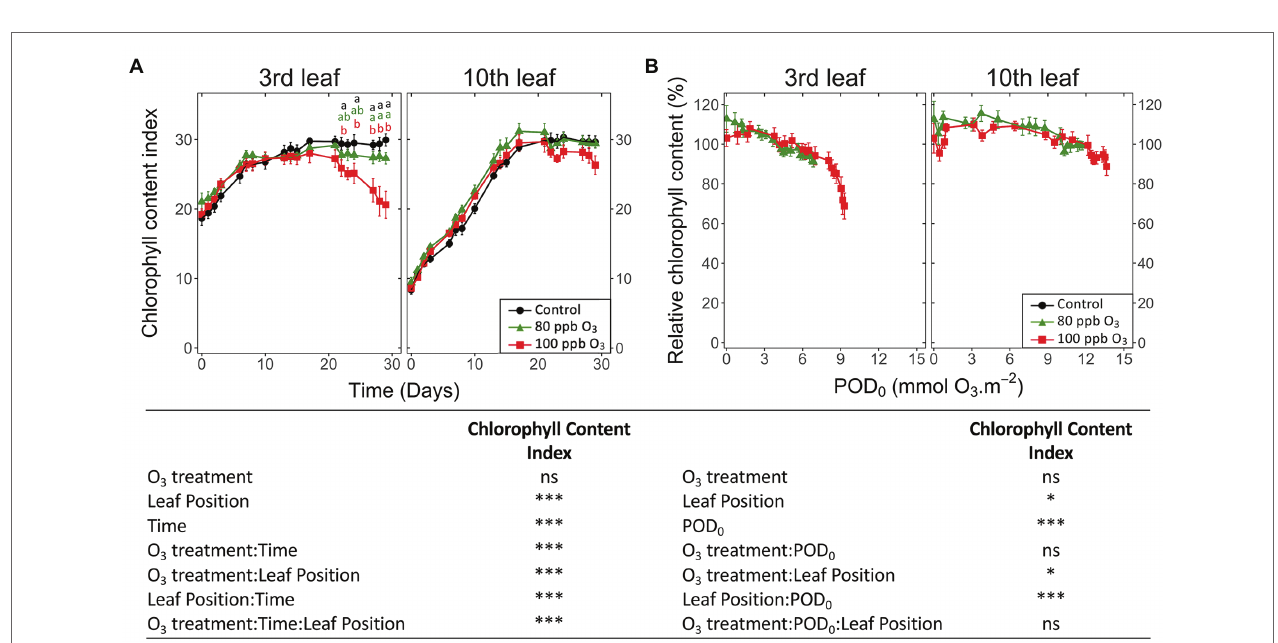
the lower palisade parenchyma ( Figures 4I – L ). Non-oxidized dead cells ( Figures 4I,J ). The dark hues of oxidized lesions ( Figure 4L ) were enhanced by staining with Trypan blue ( Figures 4E,G ). Oxidized cells showed sharp wall angles indicative